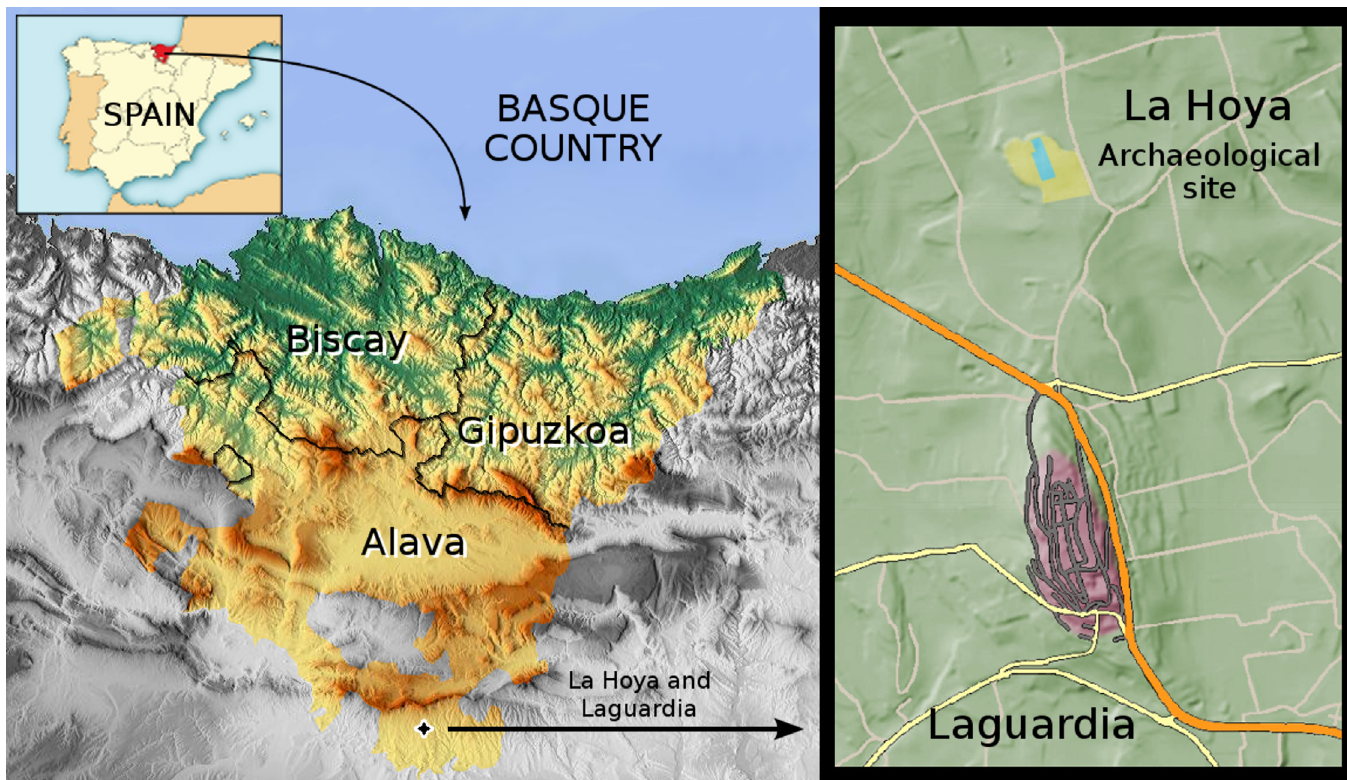
Fig 1. Enlarged view of the Basque Country and its provinces with the location of the village of Laguardia and La Hoya archaeological site (distance 1 km).